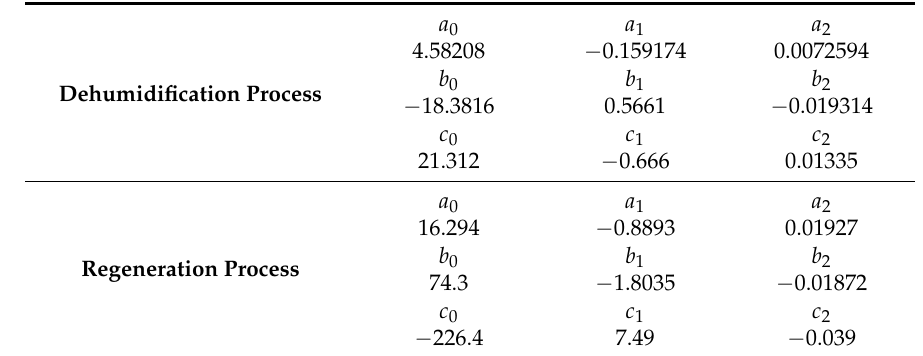
Table 3. Coefficients of vapor pressure